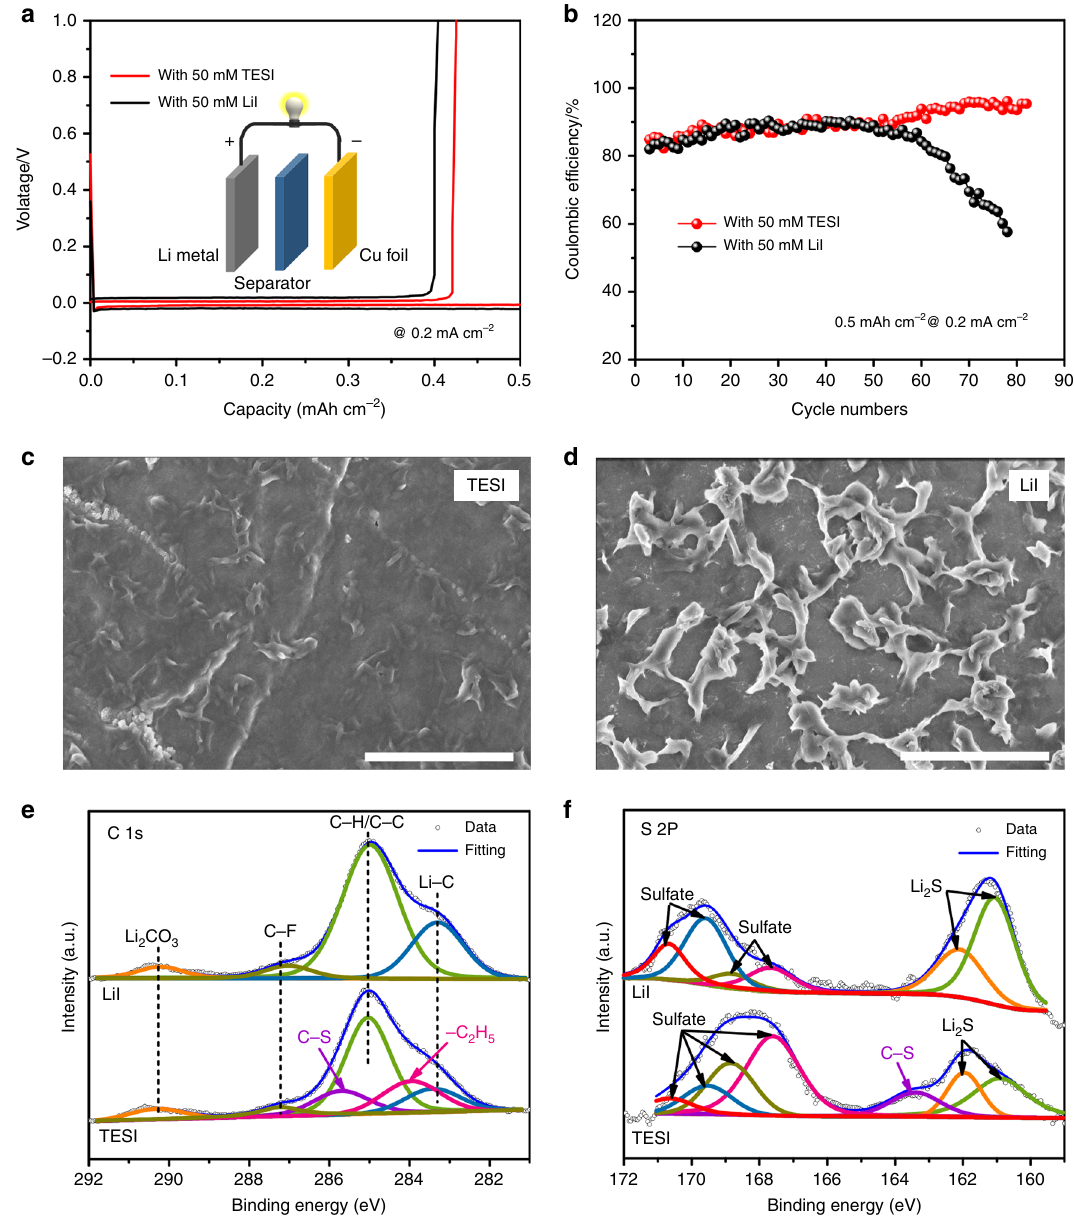
Fig. 8 Electrochemical performance and analysis of the Li anodes of Li | Cu cells with a limited speci fi c capacity of 0.5 mAh cm − 2 . a Galvanostatic discharge/charge pro fi le at 0.2 mA cm − 2 . b Subsequent cycles, current density: 0.2 mA cm − 2 . c SEM image of the Li anode after 80 cycles with 50 mM TESI additive. Scale bar is 2 μ m. d SEM image of the Li anode after the 80 cycles with 50 mM LiI additive. Scale bar is 2 μ m. e C 1s XPS spectra of the Li anodes after 80 cycles. f S 2p XPS spectra of the Li anodes after 80